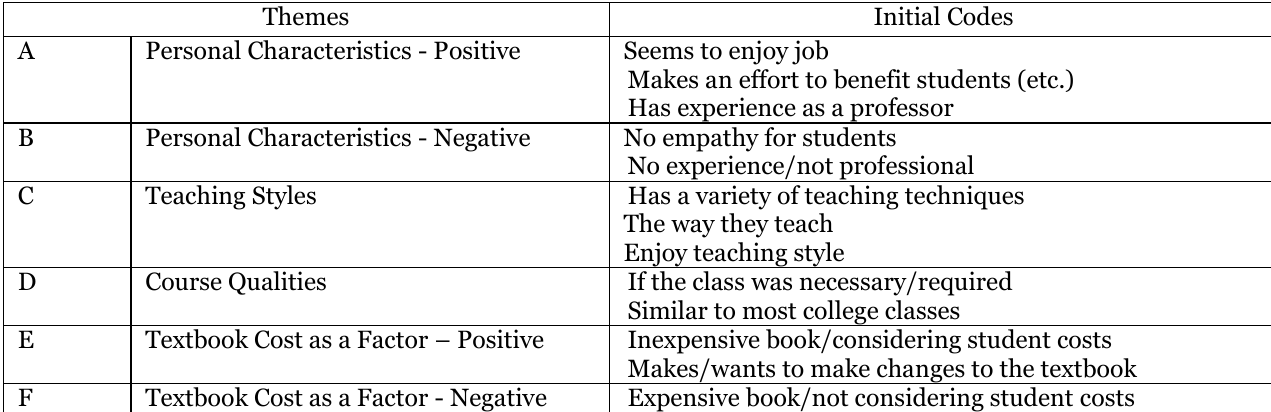
Main Themes of Participants’ Justifications for Perceptions of